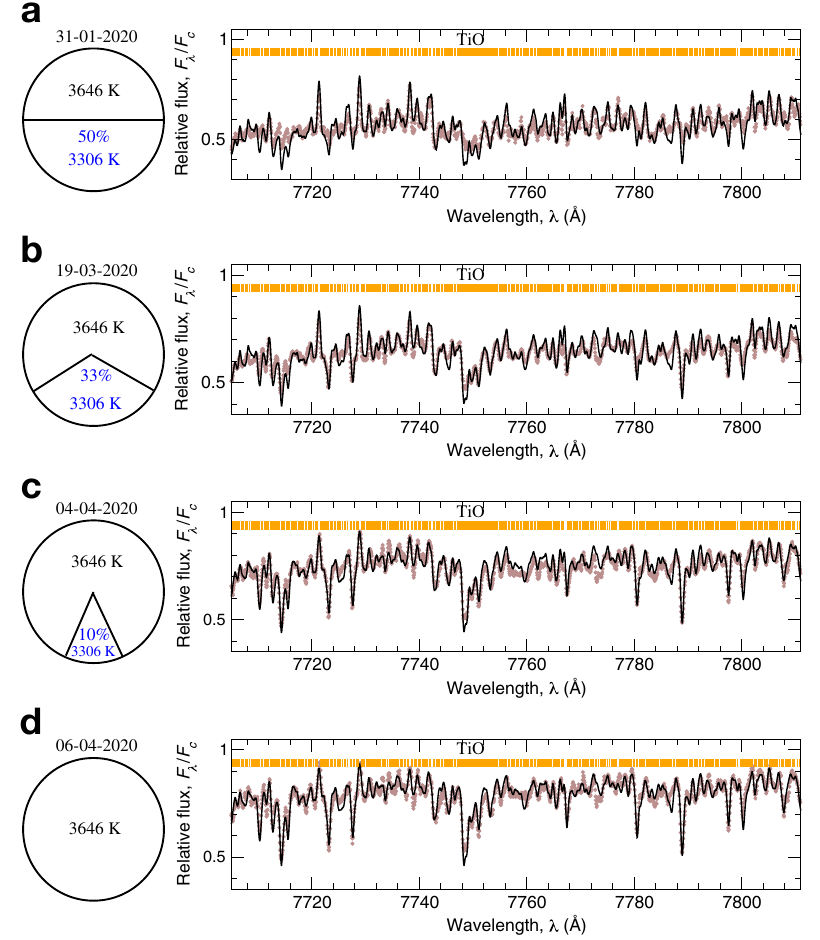
Fig. 2 The schemes of the stellar surface with a dark spot and the corresponding best fi ts of the narrow spectral region 7705 – 7811 Å for four dates of observations. The temperature increasing is interpreted as the changing of the surface area of a dark spot. Relative fl ux is calculated as a ratio of the fl ux at a particular wavelength ( F λ ) to the fl ux in continuum ( F c ). The observed spectra are shown as brown dots. The theoretical spectra (black solid curves) were calculated with the obtained parameters from Table 1 and convolved with the instrumental pro fi le. Everywhere V mic = 3 km s − 1 , V sin i = 5 km s − 1 , V mac = 16 km s − 1 . Titanium, carbon, nitrogen, and oxygen abundances are taken to be 4.95, 8.43, 8.60, and 8.80 dex, respectively. The molecular TiO (titanium oxide) lines are marked by vertical lines on each panel. a On 31-01-2020, the temperature of the spot is 3306 K if it occupies 50% of the surface area. b